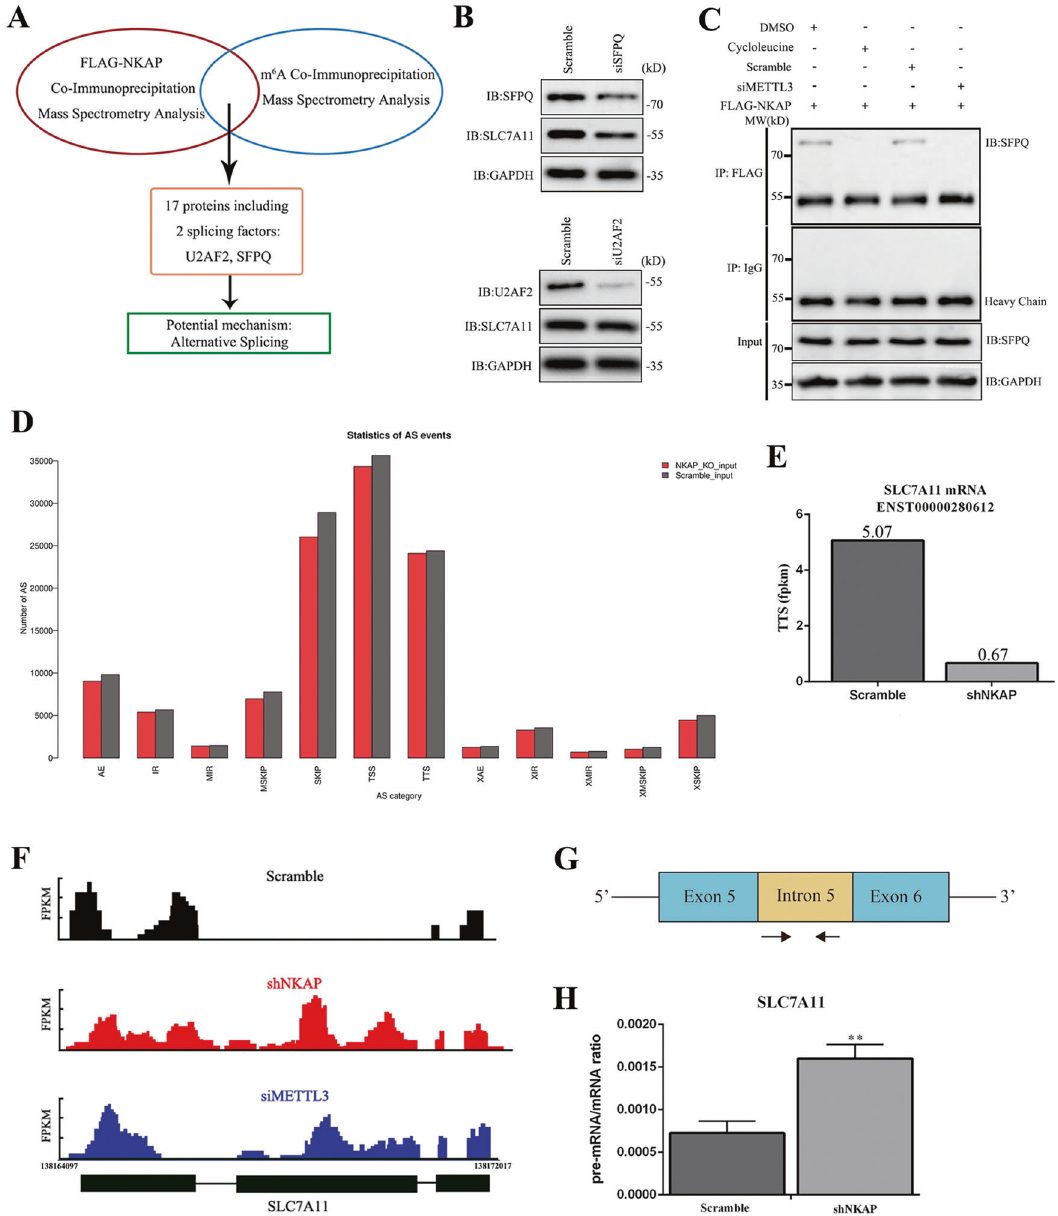
Fig. 6 NKAP recruited SFPQ to regulate the TTS splicing event and mRNA maturation. A Schematic of Co-IP experiment and proteomic screening by MS to identify the potential mechanism. B SFPQ knockdown decreased protein levels of SLC7A11. U2AF2 knockdown had no effect on SLC7A11 expression. C Co-IP analysis of the interaction between Flag-NKAP and SFPQ, which could be blocked by treatment with either cycloleucine or METTL3 RNAi. D Chart showed ASpro fi le analysis and statistics of alternative splicing events for all transcripts based on high-throughput RNA sequencing. E Decreased occurrence of alternative transcription termination site (TTS) on the SLC7A11 transcript. F Sashimi plots showing retained exon on the SLC7A11 transcript in both shNKAP and siMETTL3 groups. G Schematic representation of strategy to identify intron (unspliced, pre-mRNA). H qPCR showed that the pre-mRNA/mRNA ratio of SLC7A11 increased signi fi cantly in the shNKAP group. GAPDH was used as an internal control in western blot. All bars show mean ± SD of three independent experiments. * P < 0.05, ** P < transcript showed a signi fi cant decrease in the occurrence of TTS RNAi, which implied that NKAP recruited SFPQ after binding to as measured by FPKM (Fig. 6E). Next, we used MISO [48] to m 6 A (Fig. 6C). Alternative splicing events mainly included exon quantify the relative expression of alternatively spliced exons in skipping (SKIP) and cassette exons (MSKIP), retention of single (IR) the scramble, NKAP knockdown, and METTL3 knockdown cells. We and multiple (MIR) introns, alternative exon ends (AE), alternative found that NKAP and METTL3 regulated the common alternative transcription start site (TSS), and alternative transcription termina- splicing event TTS, and the same exon was retained in the tion site (TTS) [46, 47]. We used ASpro fi le to perform qualitative SLC7A11 transcript (Fig. 6F). We attempted to design the speci fi c and statistical analysis of alternative splicing events for all primer of SLC7A11 pre-mRNAs. We designed a pair of primers transcripts predicted by Stringtie based on the RNA-sequence re fl ecting SLC7A11 pre-mRNA level in U87MG. The primer of (Fig. 6D). The analysis of splicing event changes of the SLC7A11